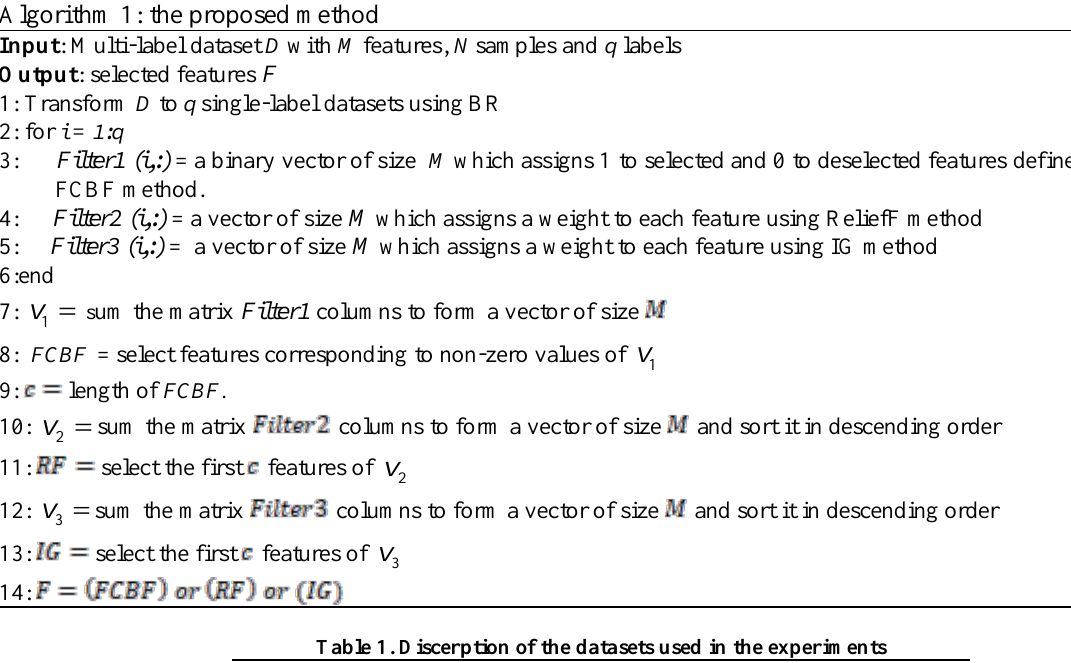
Algorithm 1: the proposed method